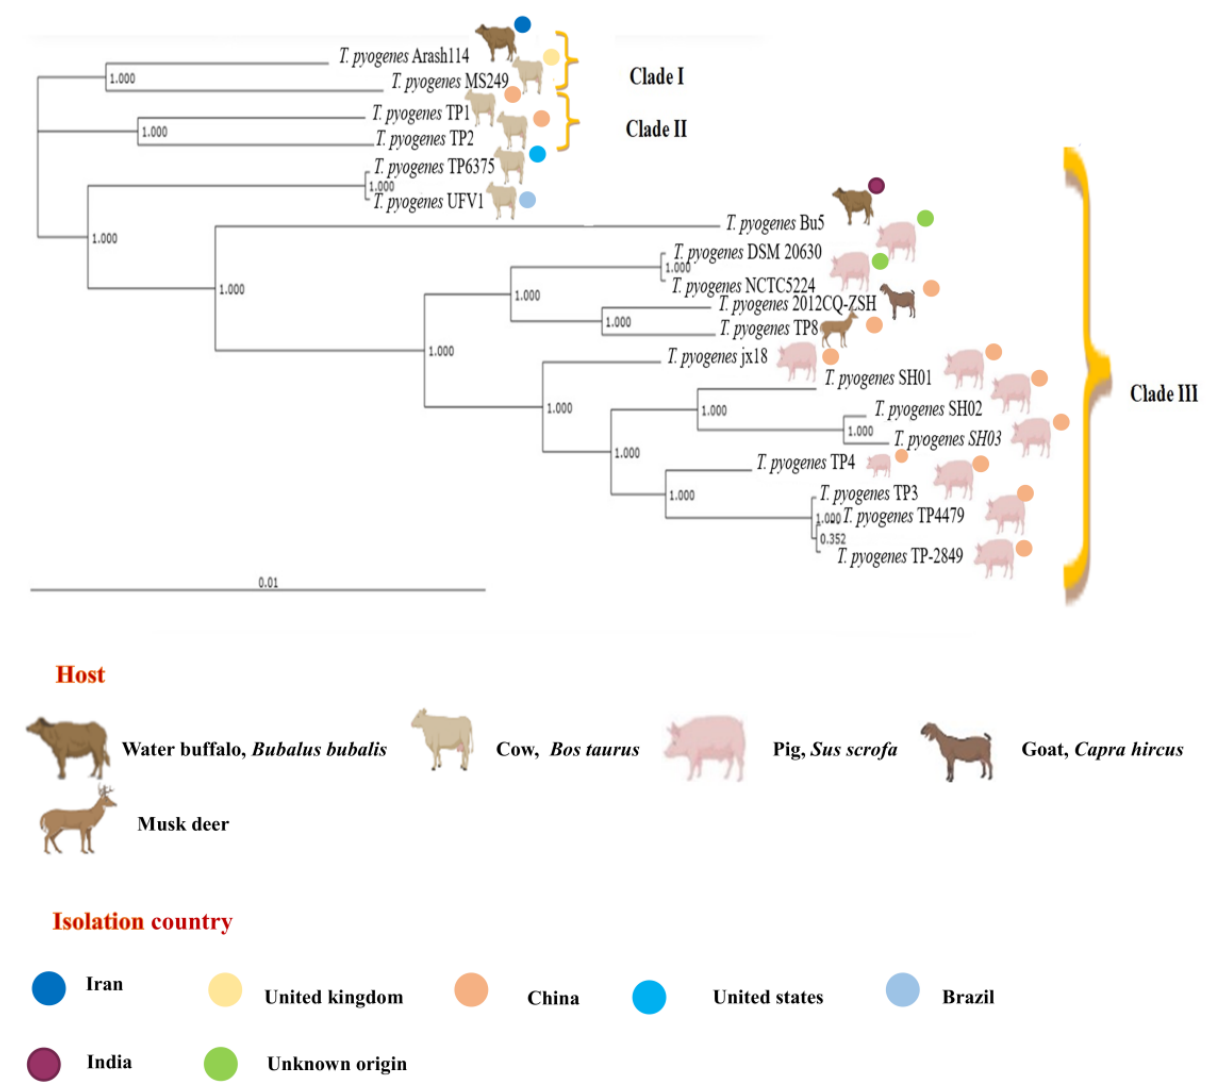
Figure 5. Phylogenetic tree constructed on the basis of core-genome of 19 investigated T. pyogenes genomes by EDGAR. The hosts associated with the strains and isolation countries are depicted. The phylogenetic tree can be divided into three clades i.e., clade I, cladeII, and clade III, wherein clade III is harboring the maximum number (11) of strains. The majority of the internal branches have maximum branch support value.